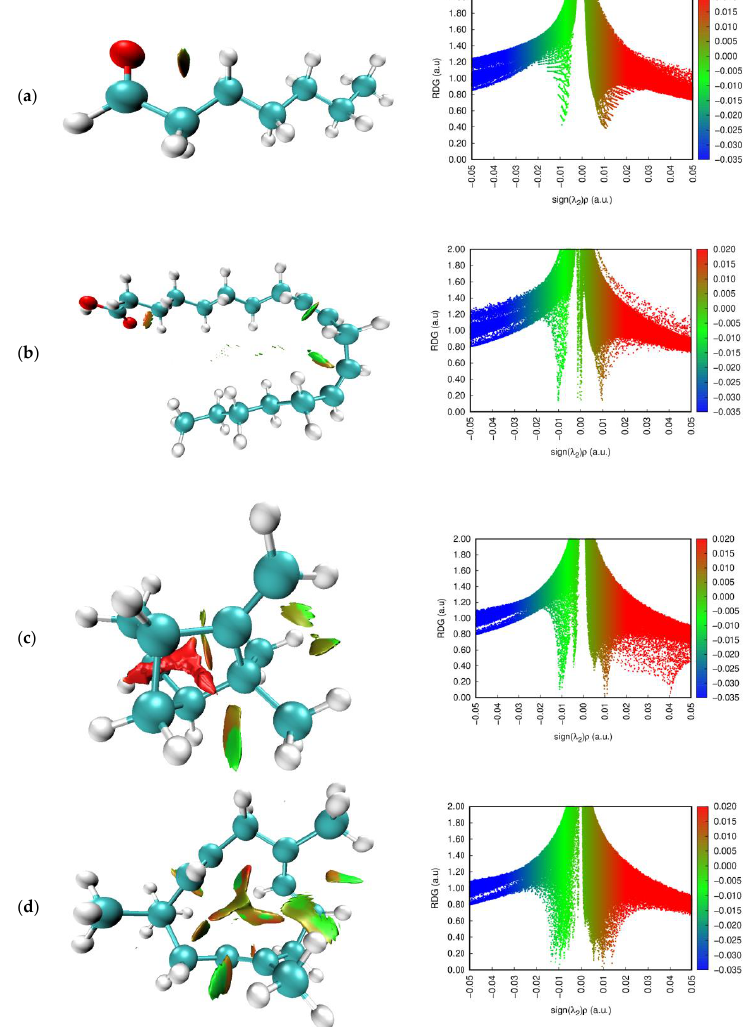
Figure 5. NCI (left) and RDG (right) plots of the studied molecules ( a – d ). Figure 5. NCI ( left ) and RDG ( right ) plots of the studied molecules ( a – d The condensed Fukui functions are determined to characterize the regioselectivity of an atom ‘r’ in a molecule. For this purpose, Fukui functions (f + (r), f − (r), f 0 (r), Δf(r)) were